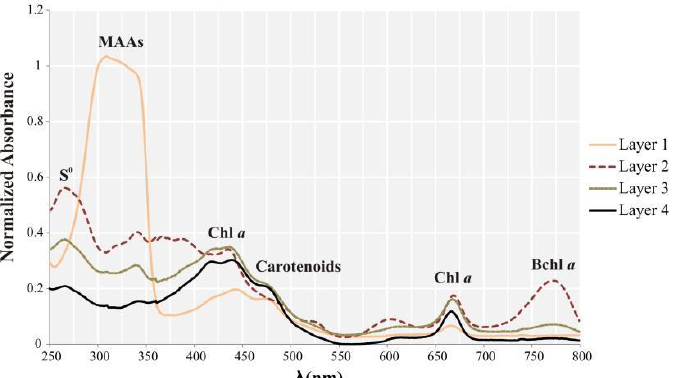
Figure 7. Total absorbance spectra of the pigments extracted with methanol from the four layers individually.